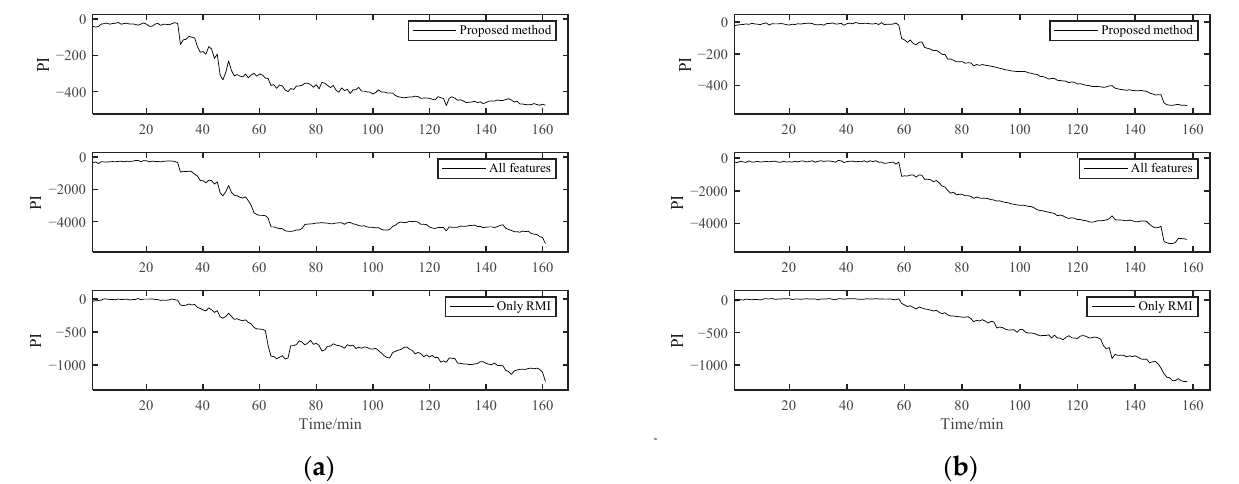
Figure 25. Comparisons with different methods: ( a ) Bearing 1-2; ( b ) Bearing 1-3.